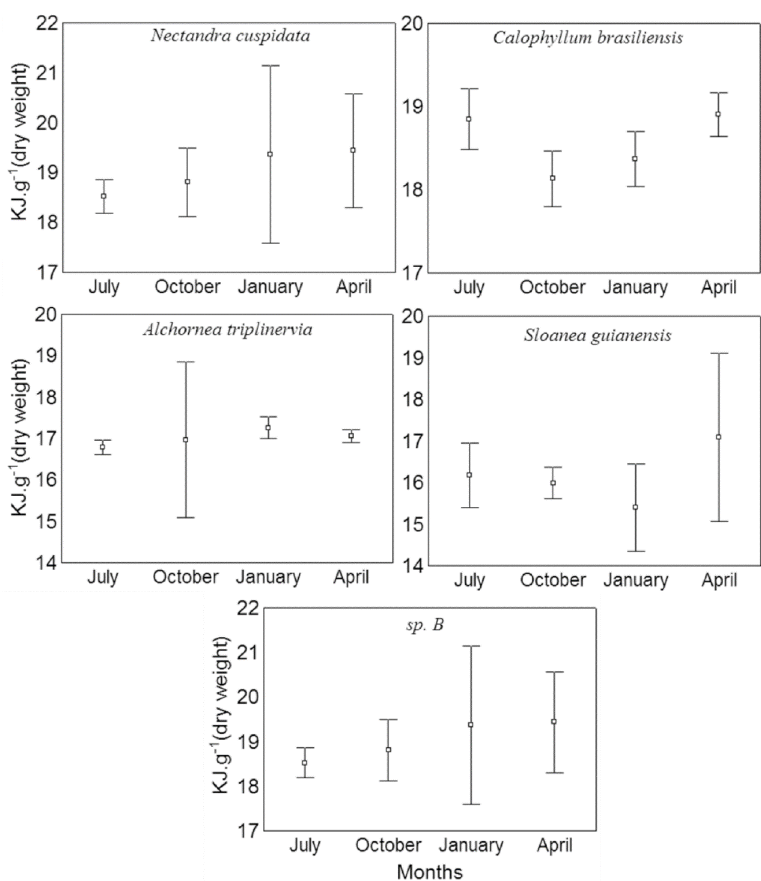
Figure 3. Temporal variationin the caloric content of tree leaves from CES riparian area. Mean (box) and stan- dard deviation (line). Please note that graphics have different Y-axis scales, in order to better visualize the results. sp. B = specie of the Bignoniaceae